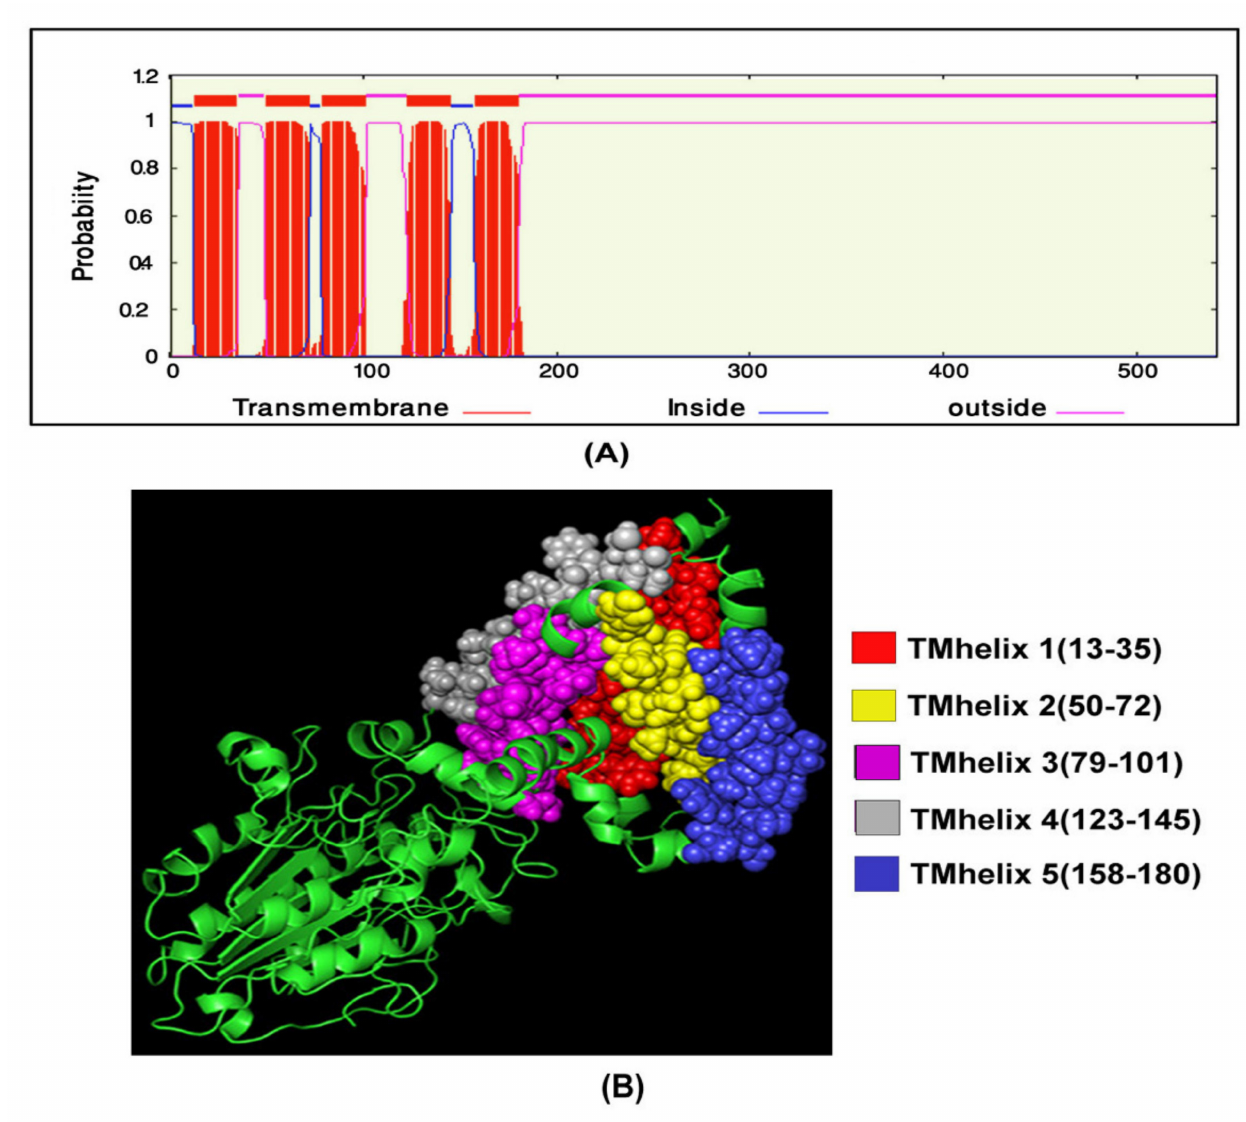
Figure 4. SAUVM MCR-1 protein transmembrane topology prediction. The TMHMM